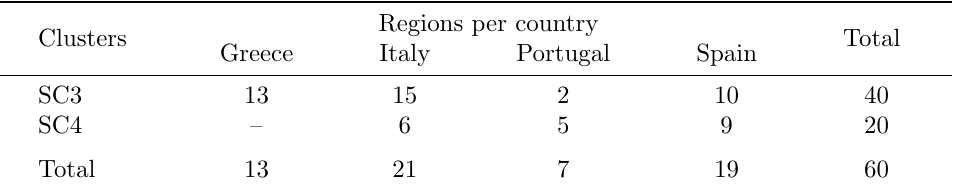
Table 11: Regions per country. Clustering based on the regions’ poverty and environmental